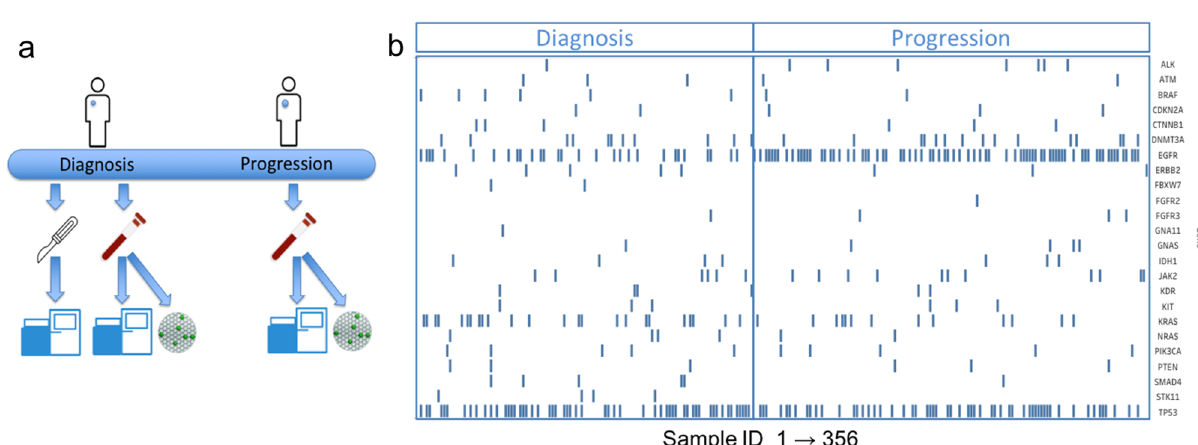
Figure 3. ( a ) Tissue samples were obtained and sequenced at diagnosis. Liquid biopsy blood samples are obtained either at diagnosis or at progression. Resulting cfDNA is sequenced via the MAP method and tested via ddPCR for a clinically-relevant set of variants. ( b ) Gene-level mutational load for all mutation-positive sequencing results at either diagnosis or progression is shown for the 24 most-detected genes as a function of sample number (x-axis). Samples were divided by timepoint: initial diagnosis (left) and progression (right). Samples are not matched and represent the population of mutation-positive samples used in the study that were obtained at each